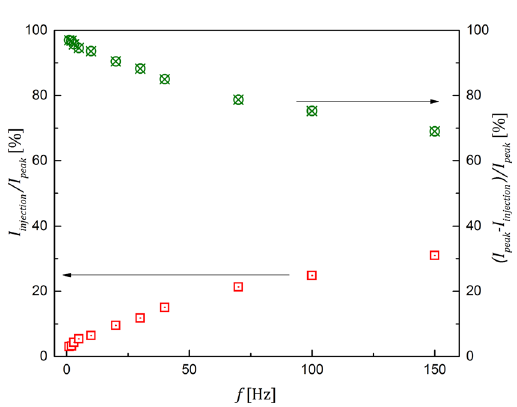
Figure 3. The ratios of I injection / I peak and I signal / I peak are plotted as a function of the chopper frequency f for F = 2 V/ μ